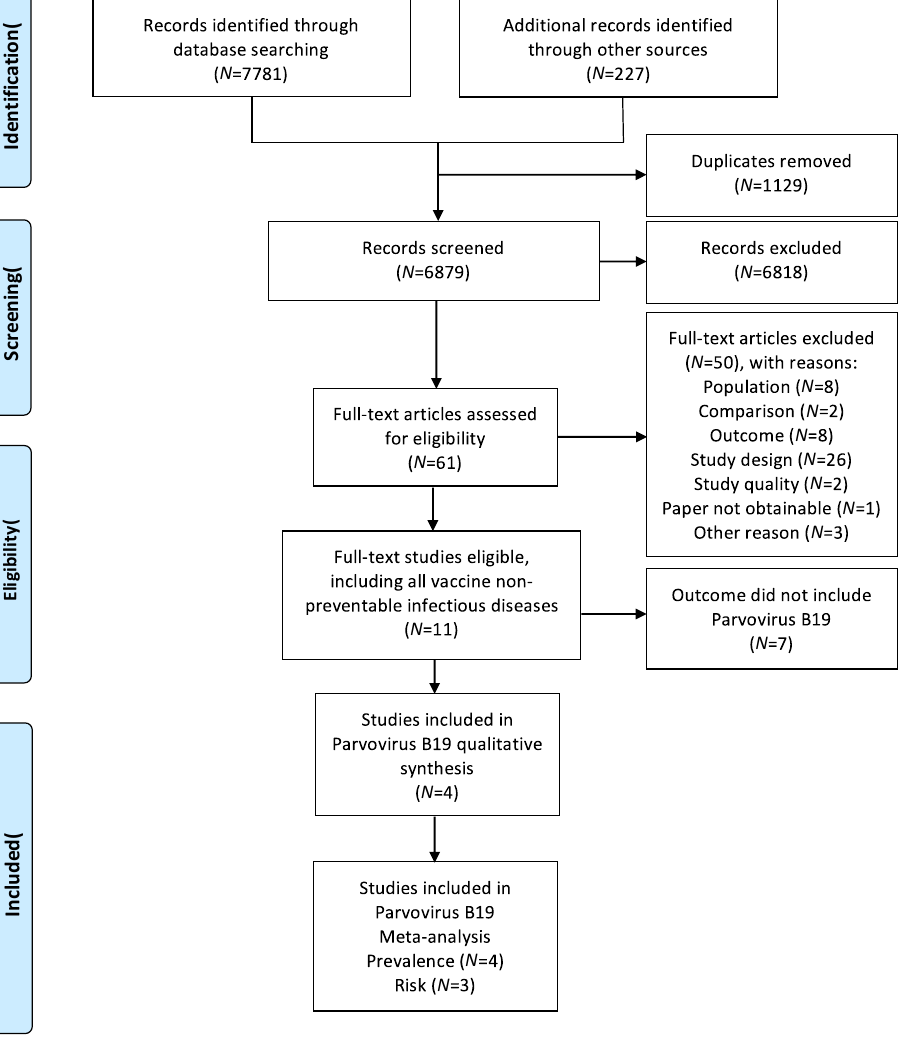
Figure 2. The study process